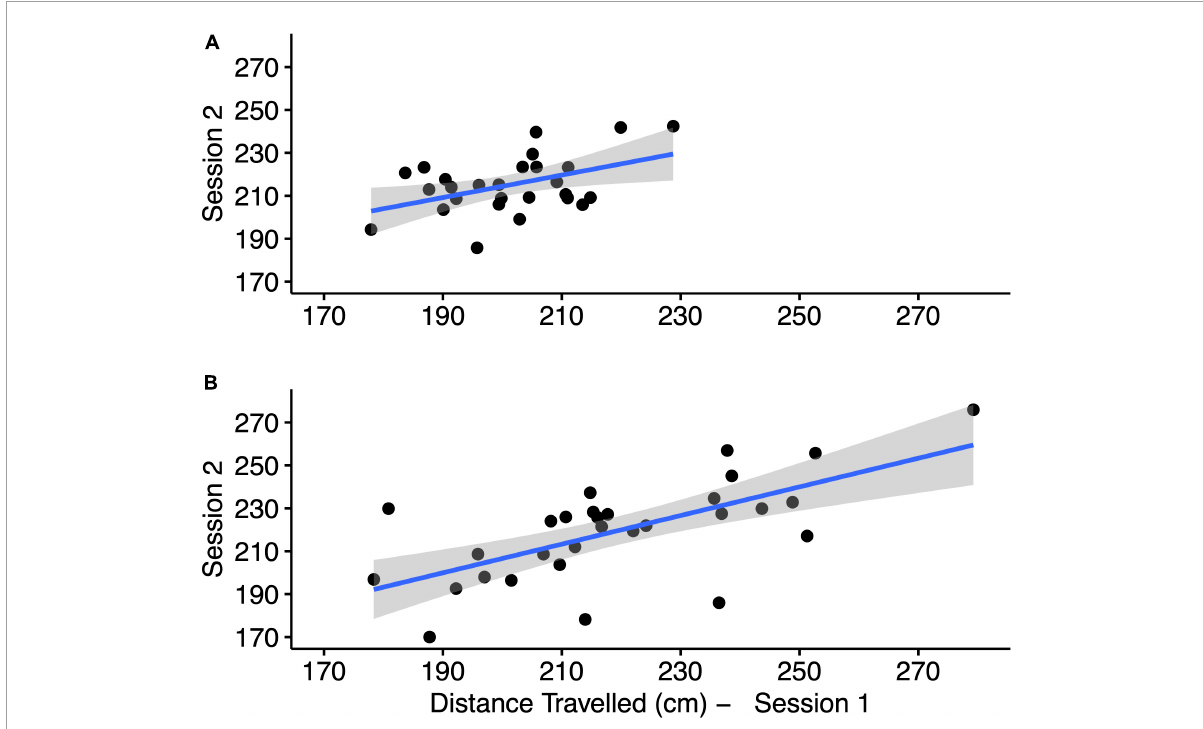
FIGURE4 Raw data with least-squares regression line for the mean of six tests from session 1 vs. the mean of six tests from session 2 for the real-world triangle competition test (A) and the VR triangle competition test (B)